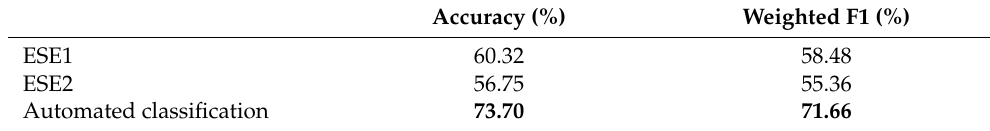
Table 11. Accuracy and weighted F1 measures for manual and automatic